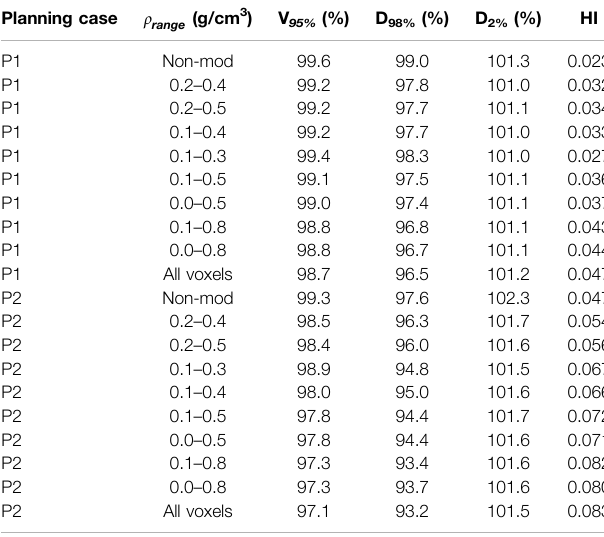
TABLE 5 | Dosimetric indices for carbon ion plans for patients P1 and P2 and P mod (cid:1) 0.400 mm for variable values of ρ range .